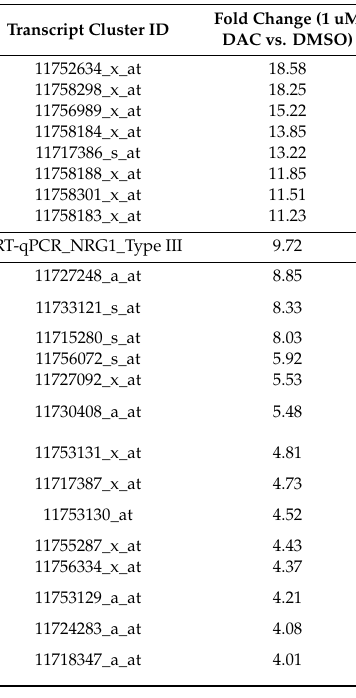
Table 2. All genes at least 4-fold upregulated on 1 µ M DAC relative to DMSO control. p -values from ANOVA for microarray probe. RT-qPCR validation for NRG1 Type III shown in bold ( p -value from Student’s 2-tailed t